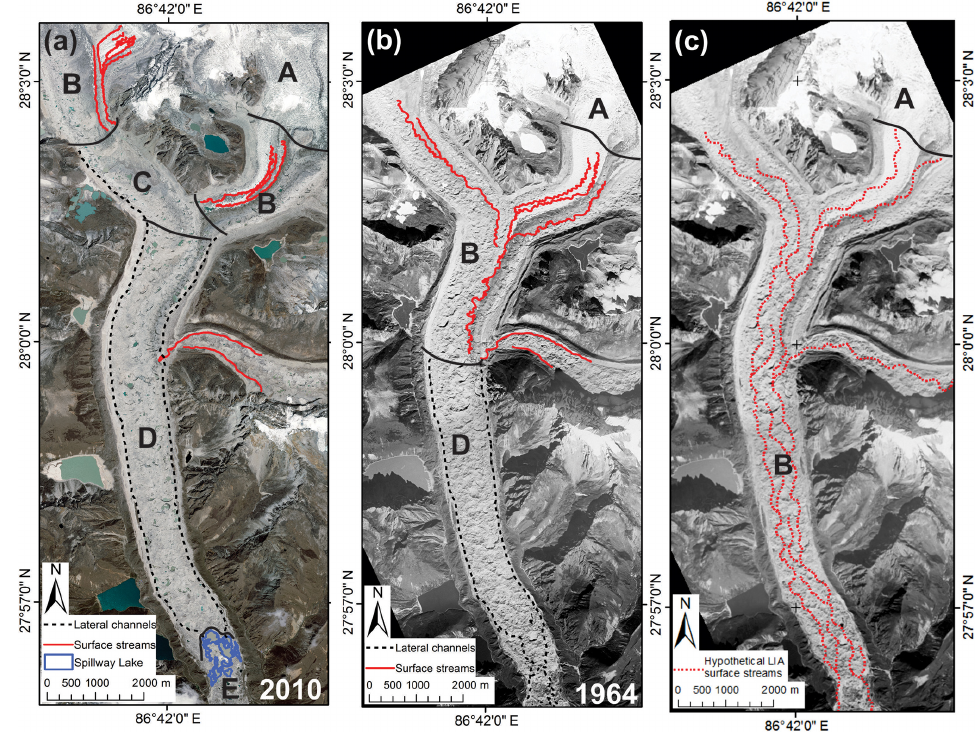
Figure 14. Zonation of the drainage system in (a) 2010 and (b) 1964, and (c) a hypothetical configuration at the Little Ice Age maximum. A: crevasse fields; B: supraglacial channels; C: transitional zone with shallow basins; D: closed surface basins with perched lakes; E: Spillway Lake. Dashed black lines indicate the positions of sub-marginal conduits.